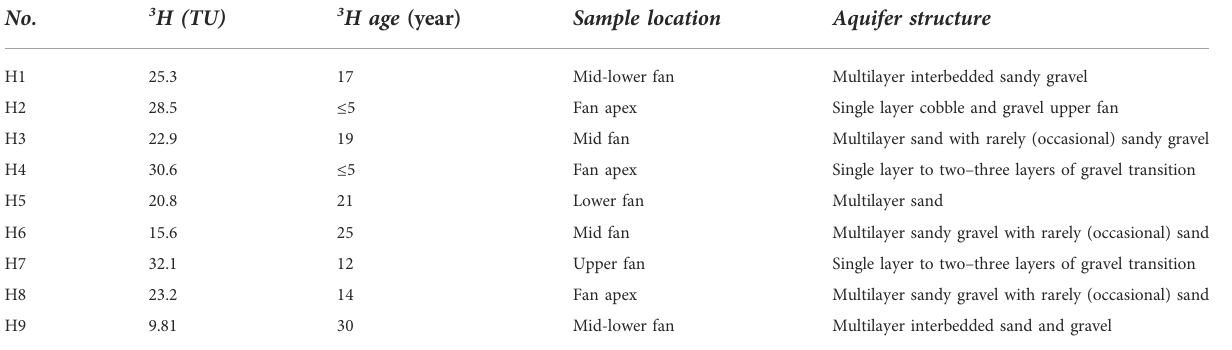
TABLE 7 Groundwater age-dating data ( 3